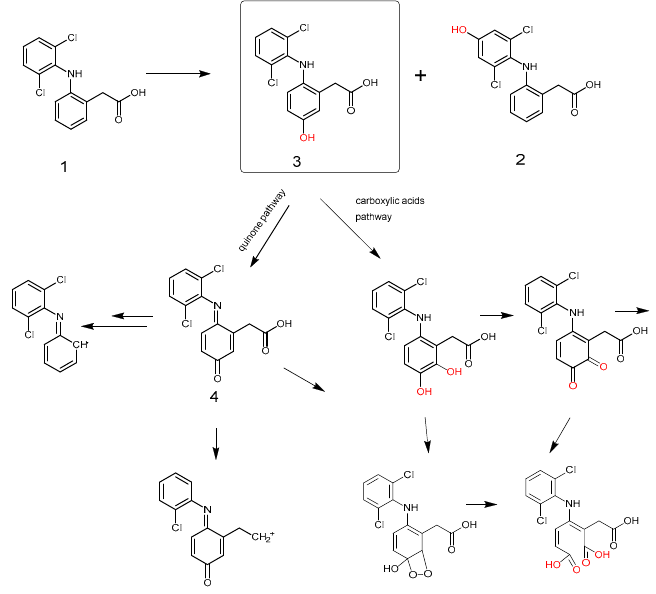
Figure 6. NMR spectra of initial diclofenac ( a ), diclofenac after interaction with sol–gel encapsulated LiP ( b ), HRP ( c ) composites at pH = 3 over 3